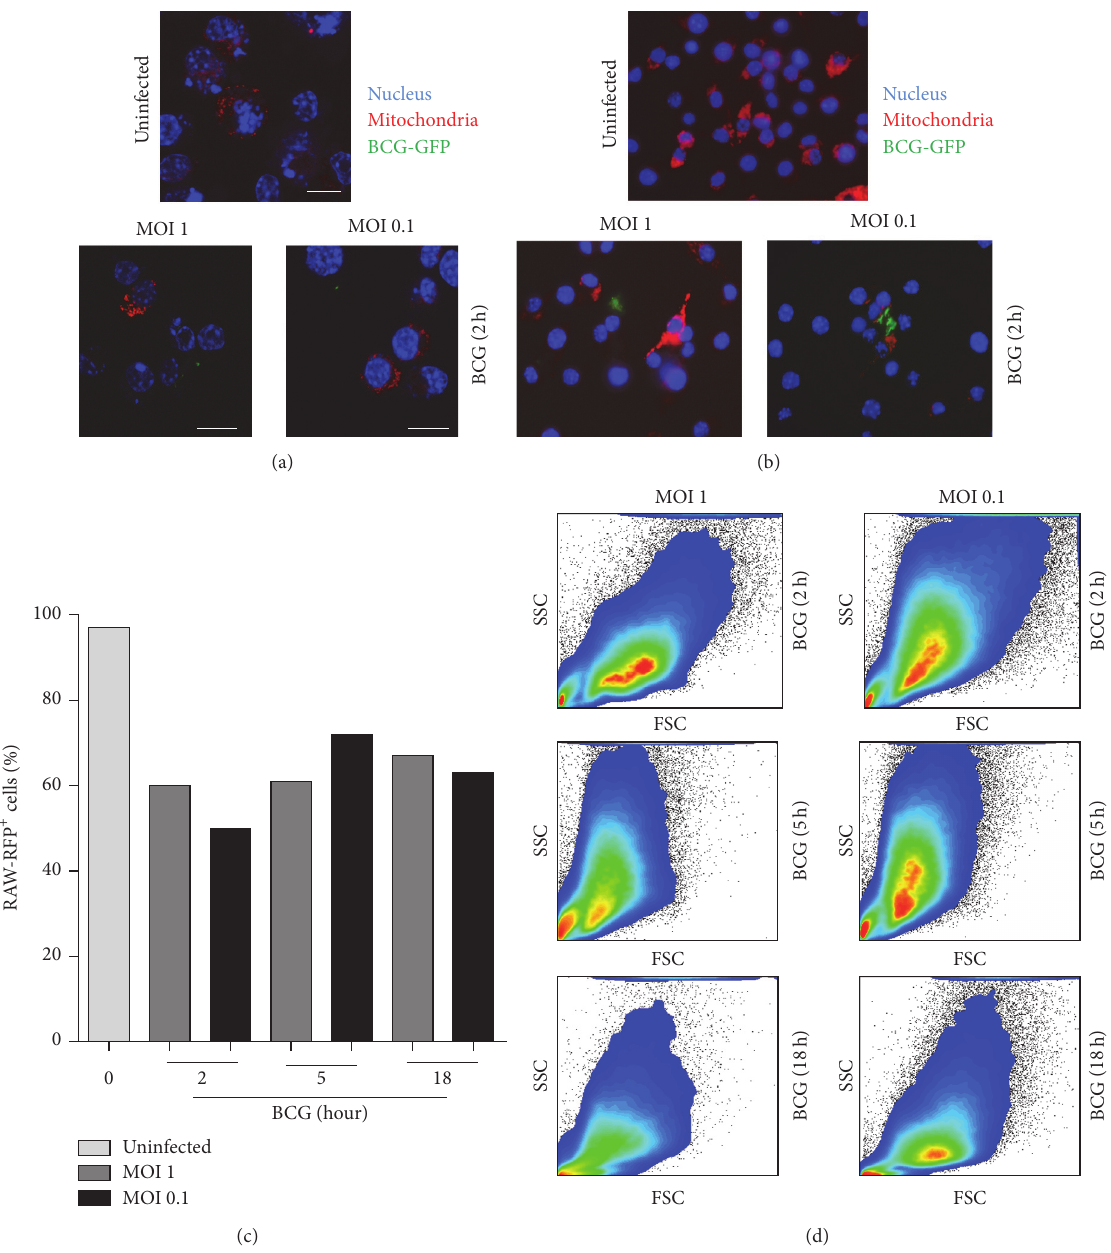
Figure 7: BCG infection at MOI 0.1 and MOI 1 maintains undisturbed mitochondrial and nuclear integrity. (a) Transfected RAW-mitoRFP macrophages and (b) transfected and sorted (enriched to 97% or RAW-mitoRFP + ) were infected at MOI 1 and MOI 0.1 BCG-GFP. Slides were prepared with DAPI and mounting medium and analyzed by confocal SP5 microscopy using Leica Application Suite software. Mitochondria (red), BCG (green), and nucleus (blue) (left panel). Scale bar 10 𝜇 m. (c) RAW-mitoRFP cells were sorted, enriched to 97% (RAW-mitoRFP + ), and infected with BCG-GFP and quantified for RAW-mitoRFP + cells before and after BCG-GFP infection at MOI 1 and MOI 0.1. (d) Flow cytometry analyses of cell integrity and size using side scatter (SSC)/forward scatter (FSC). Representative image from three independent